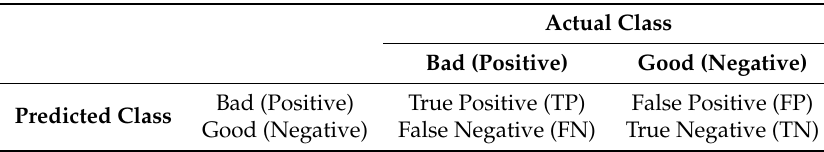
Table 3. Confusion matrix for wafer bin map